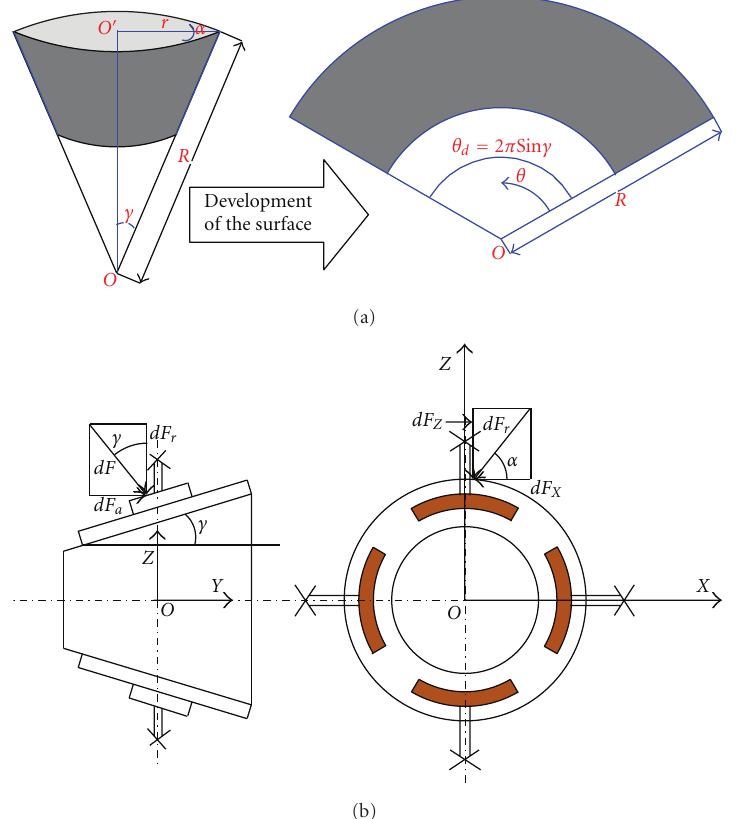
Figure 2: (a) Development of the surface of conical journal bearing. (b) Load carrying capacity distribution of a conical journal bearing.